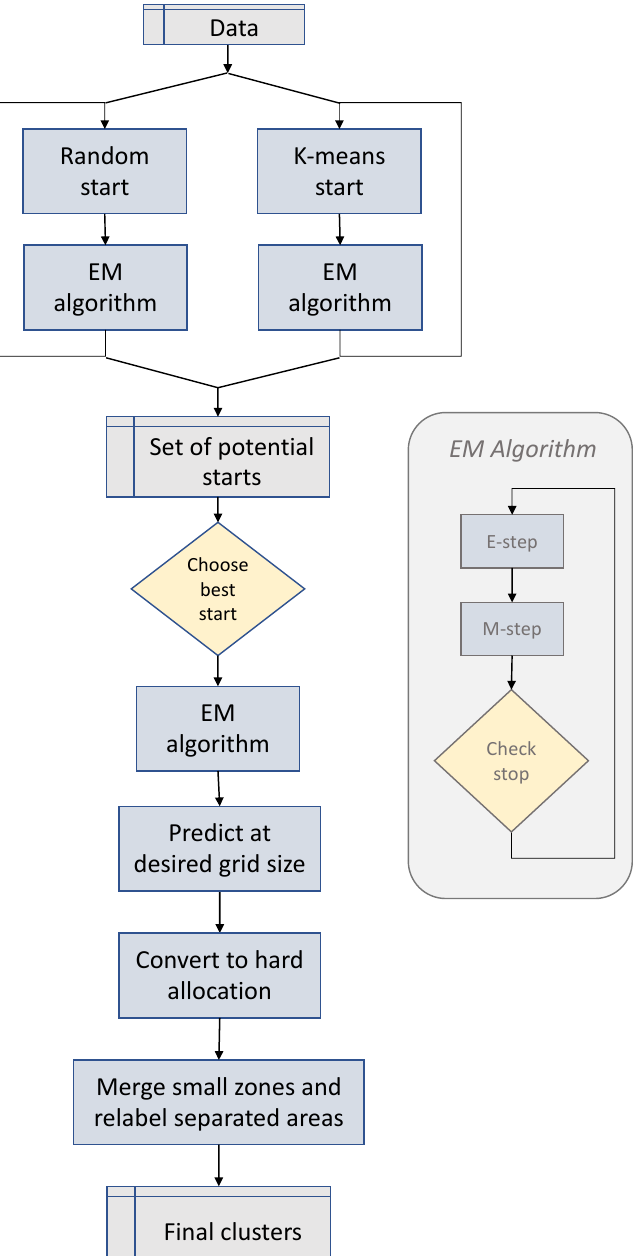
Figure 1. Flow chart of the clustering process.